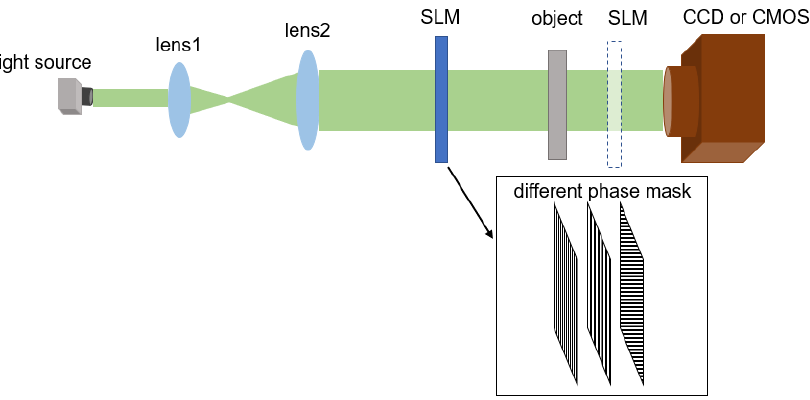
Figure 8. The system setup of resolution enhancement based on SLM.